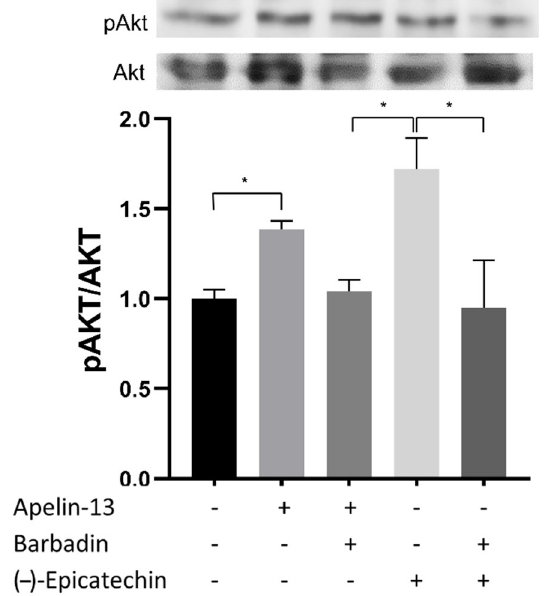
Figure 12. Acute effects (30 min) of apelin − 13 and ( ‐ ) ‐ epicatechin (EC) on upstream Akt activation. These effects were blocked by the β‐ arrestin inhibitor, Barbadin, as shown in the representative blots (each Western blot is representative of three independent experiments). Data are expressed as mean ± SD ( n = 3). * = p < 0.05 .